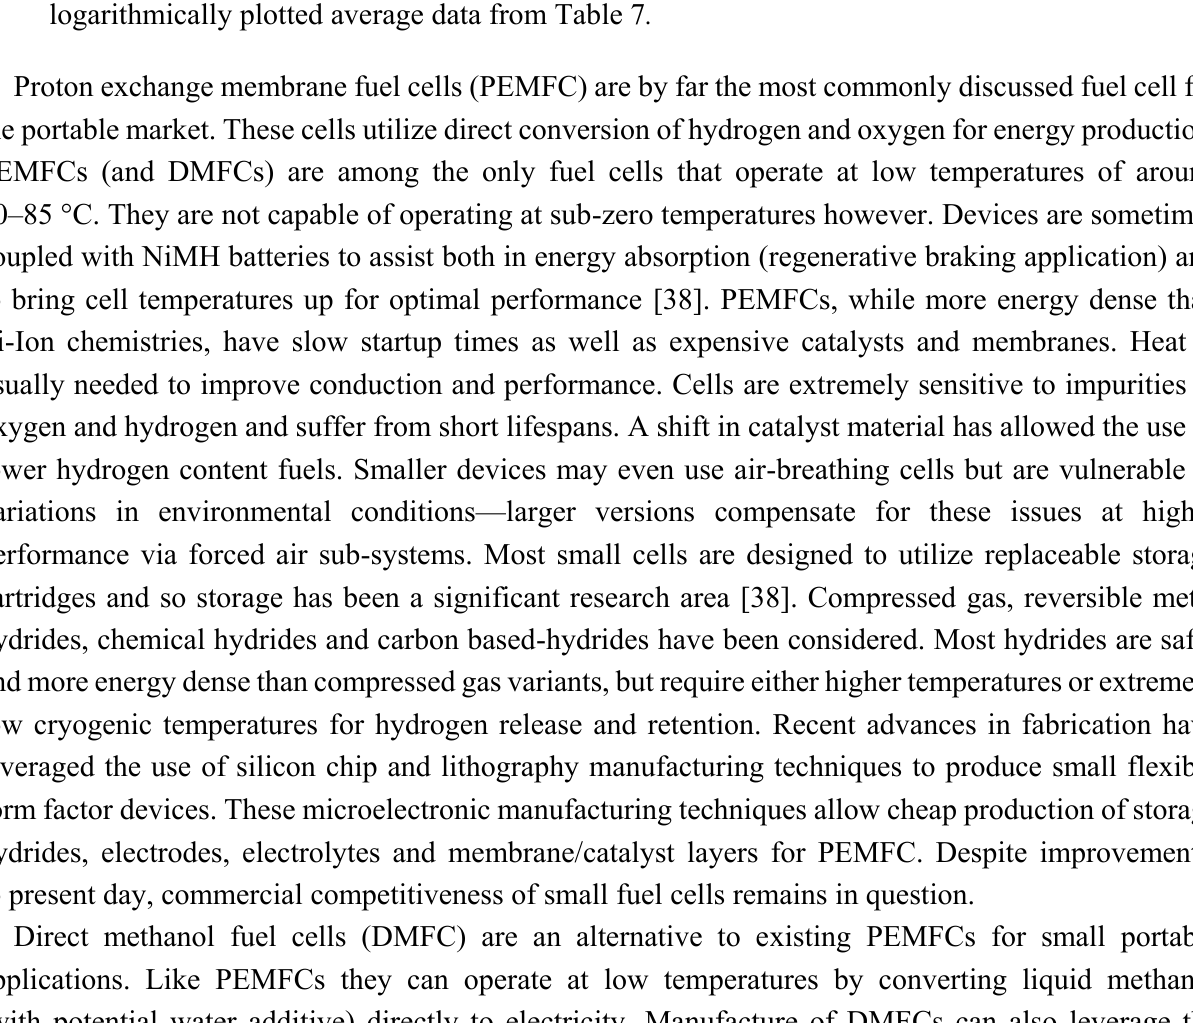
Figure 8. Comparing chemical storage and generation in fuel cells using normalized and logarithmically plotted average data from Table 7